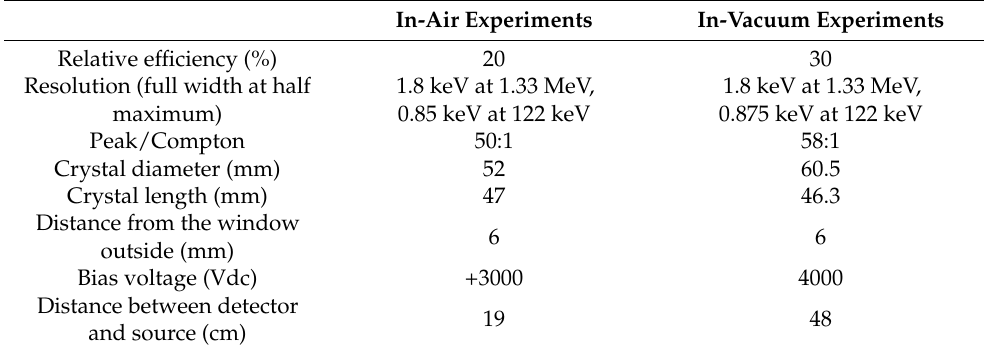
Table 1. Main characteristics of HPGe detectors used for the DBS studies with 64 Cu isotope.